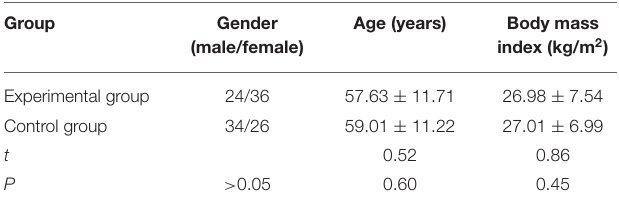
TABLE 1 | General information of patients (mean ±